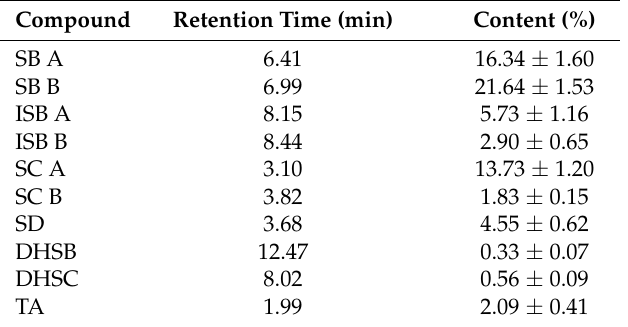
Table 1. Content of flavonolignans and taxifolin in silymarin, batch No. 17306S_089.